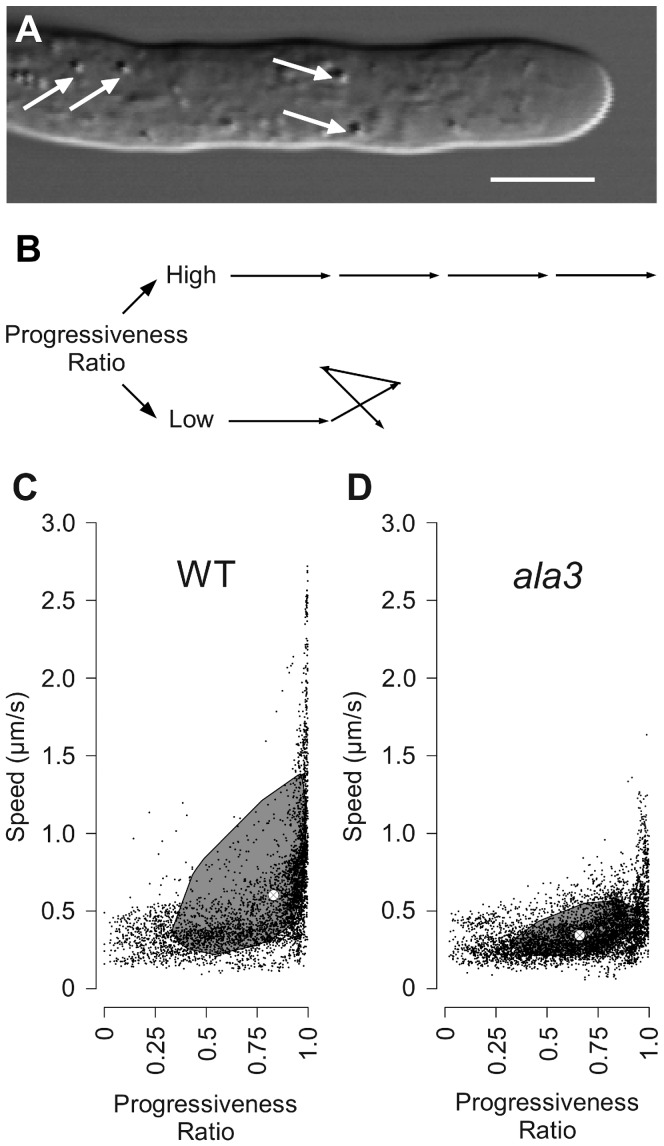
Vesicular speeds and progressiveness ratios show that vesicular movement is altered in ala3 pollen tubes.(A) Wild-type pollen tube with white arrows pointing to representative vesicles visible with DIC optics. Scale bar = 5 µM. (B) Exemplary model trajectories with high and low progressiveness ratios. (C and D) Bagplots [29] of vesicular speed and progressiveness ratios for vesicles within (C) wild-type and (D) ala3 pollen tubes. The shaded region represents an area containing 50% of the data points. The two-dimensional median is represented by the crosshairs within the shaded region. N = 7 for ala3 and n = 8 for wild-type.